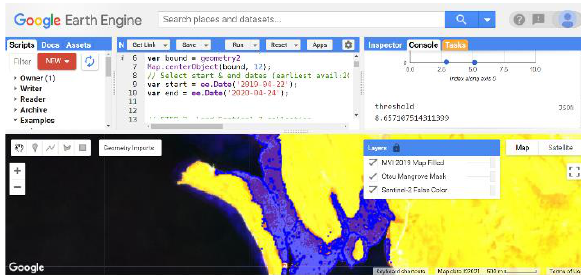
Figure 4. Products generated after running the script for the automatic identification of MVI threshold using Otsu method in